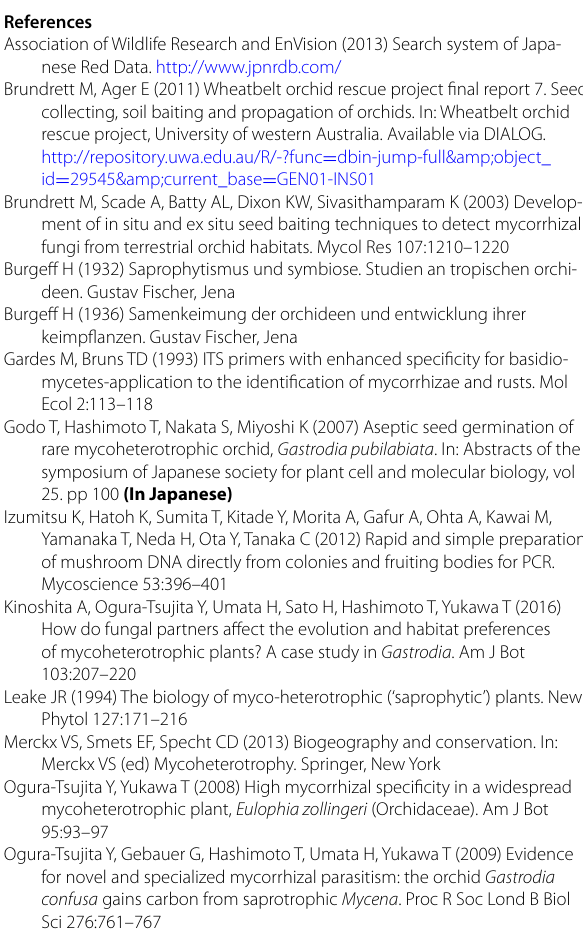
a All isolates were deposited to the Biological Resource Center of the National Institute of Technology and Evaluation (NBRC)